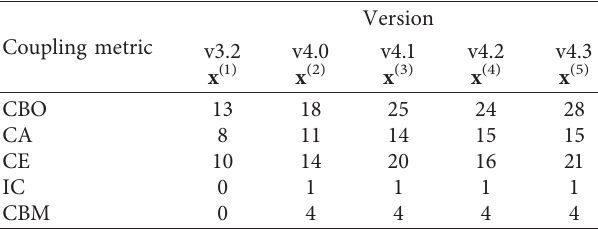
2 (e.g., the class BrowserView of